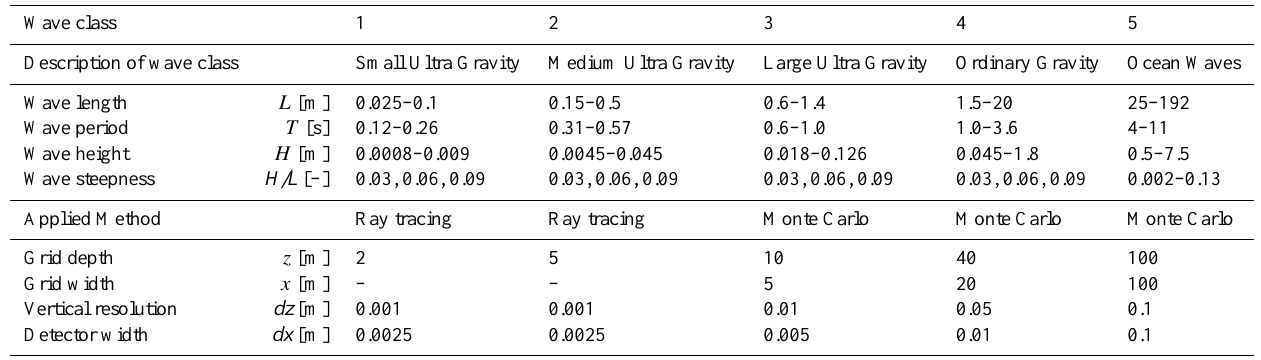
Table 3. Classification of the single wave types with details for corresponding model